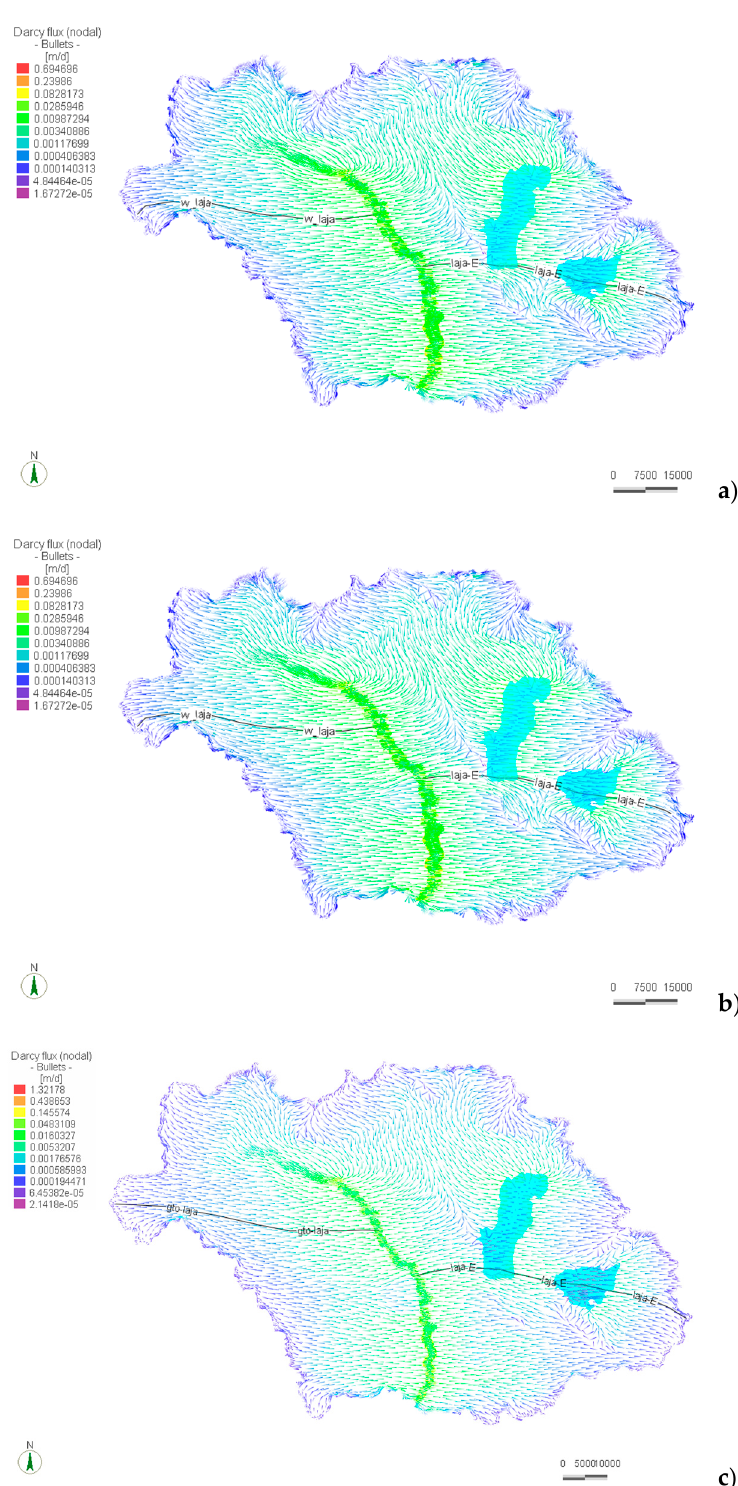
Figure 6. Nodal Darcy flux (m/d) in plan view, represented by bullets (relative length 8:1): ( a ) isothermal, scenario I; ( b ) convective 1, scenario II; and ( c ) convective 2, scenario III, see Table 1. Vertical exaggeration of the scale is 5:1.